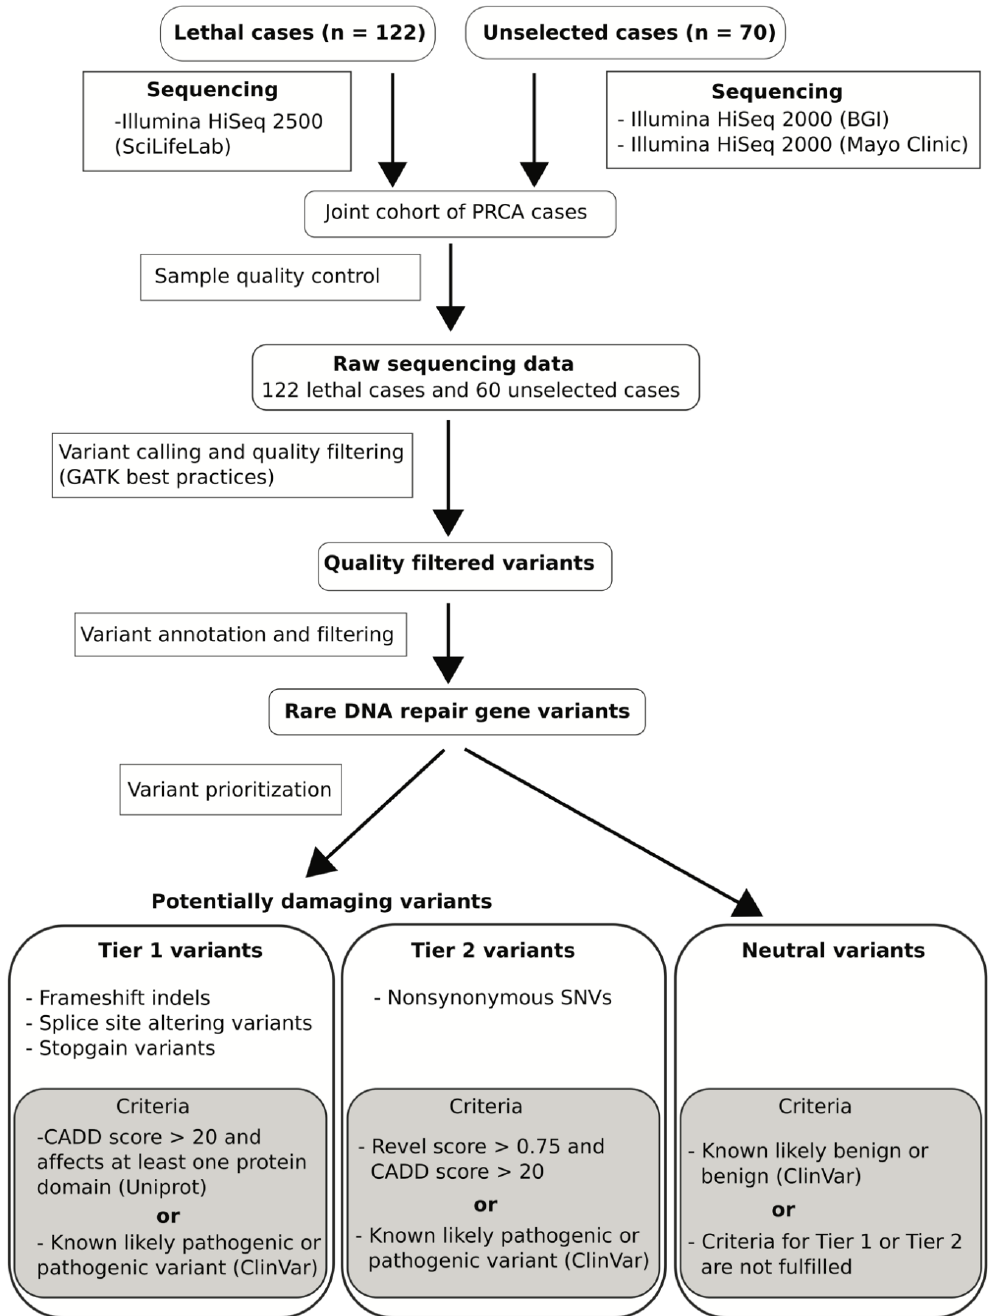
Figure 1. Flow chart describing processing of whole exome sequencing, quality control, variant calling and annotation, and variant prioritizing. PRCA: prostate cancer; ClinVar: database of reported associations of variants to clinical phenotypes; CADD: combined annotation dependent depletion; Revel: rare exome variant ensemble learner.